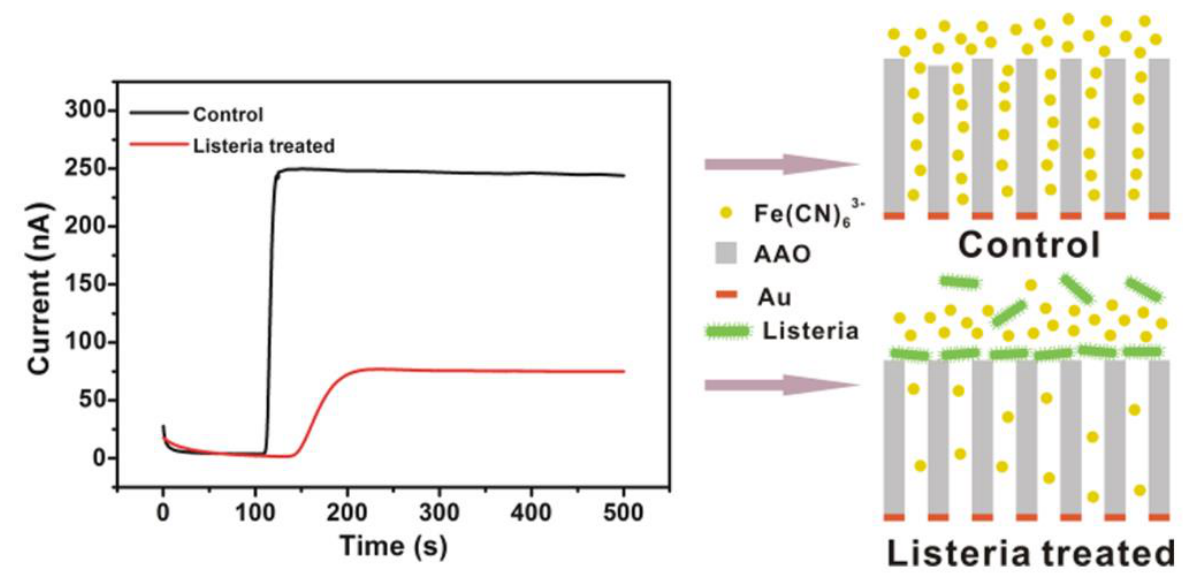
Figure 1. A schematic illustration of an electrochemical amperometric biosensor developed for Listeria detection. Copyright (2022) American Chemical [36].